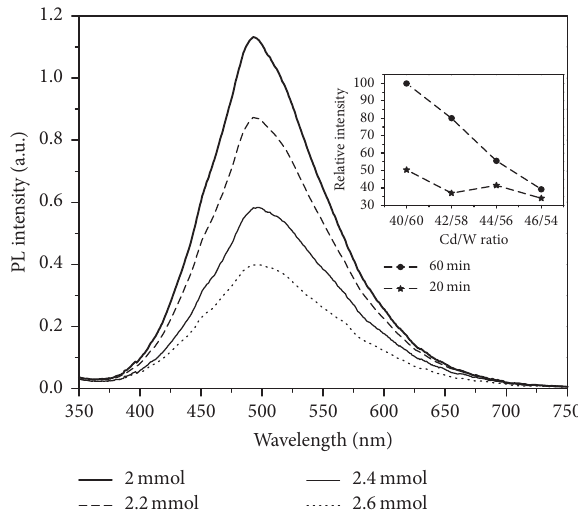
Figure 4: PL emission spectra of samples prepared with different cadmium precursor (CdO) amounts and reaction time of 60 min. The inset shows the total light output, for reaction times of 20 min and 60 min, obtained from the area under the luminescence curves, as function of Cd/W atomic ratio, as determined by EDX.